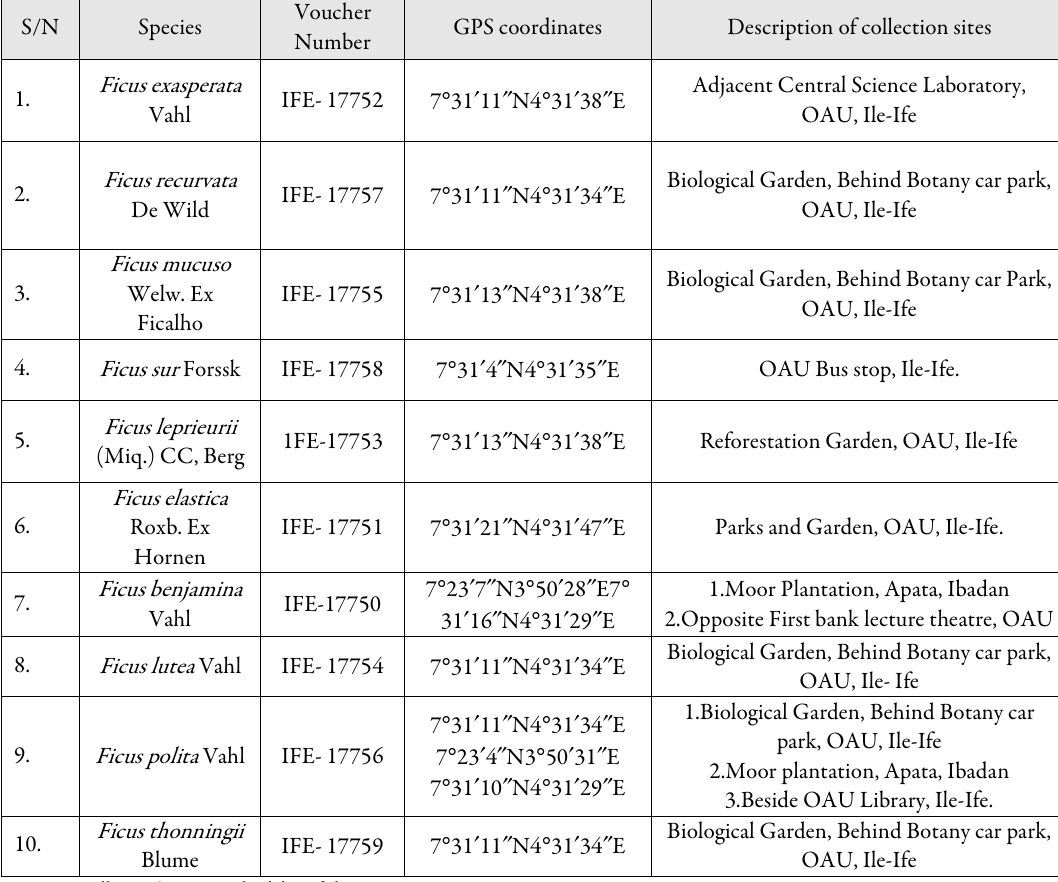
Table 1. The sites of collection and the coordinates of the Ficus species studied S/N